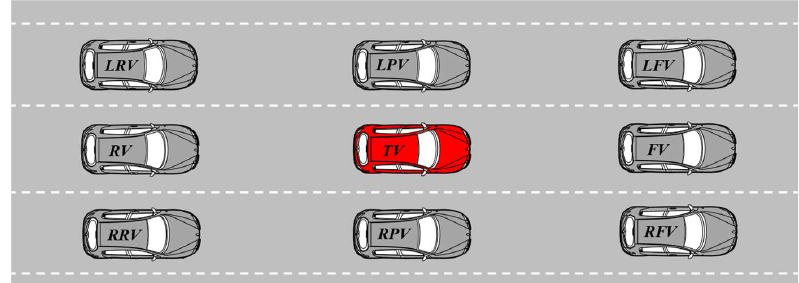
Table 7. Lane-changing intention recognition feature.